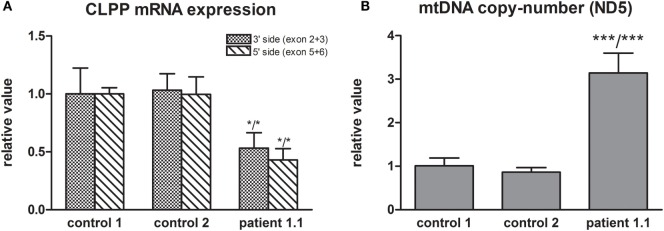
(A) CLPP mRNA expression was measured using a primer pair at the 3′ side (exon 2 and 3) and 5′ side (exon 5 and 6) of the transcript (NM_006012) and was normalized to TBP. Approximately 50% lower CLPP mRNA levels were found in patient 1.1 fibroblasts compared to controls. (B) mtDNA copy number was measured based on ND5 copy number and was normalized to nuclear B2M. Approximately a threefold copy number increase was measured in patient 1.1 (proband) fibroblasts compared to control fibroblasts.